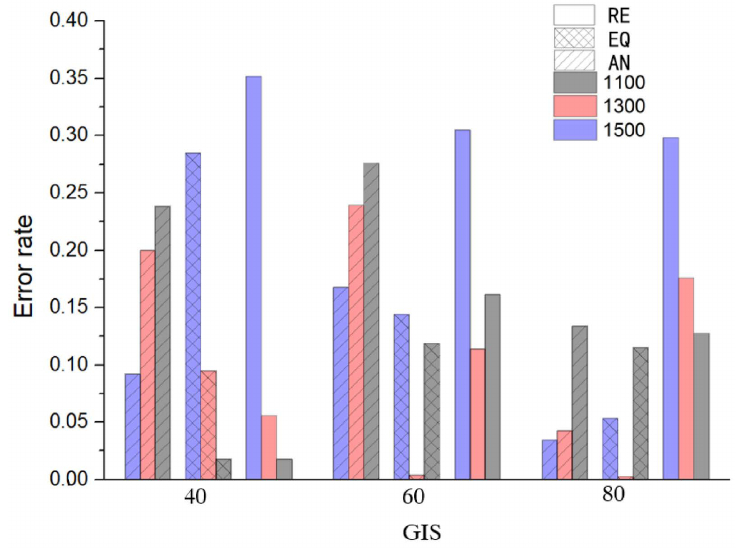
Figure 14. Error rates distribution of plastic zone under different methods, different GSI values, and different depths.